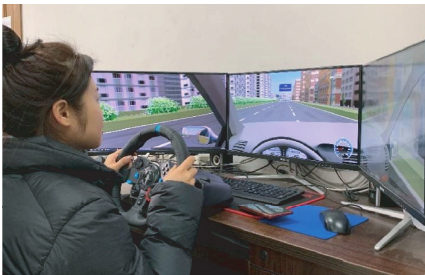
Figure 1: Driving simulation equipment.